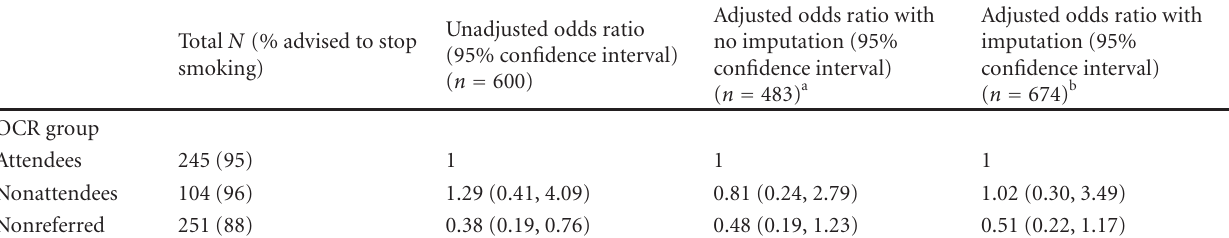
Table 5: Association between participation in outpatient cardiac rehabilitation and self-reported receipt of advice to quit